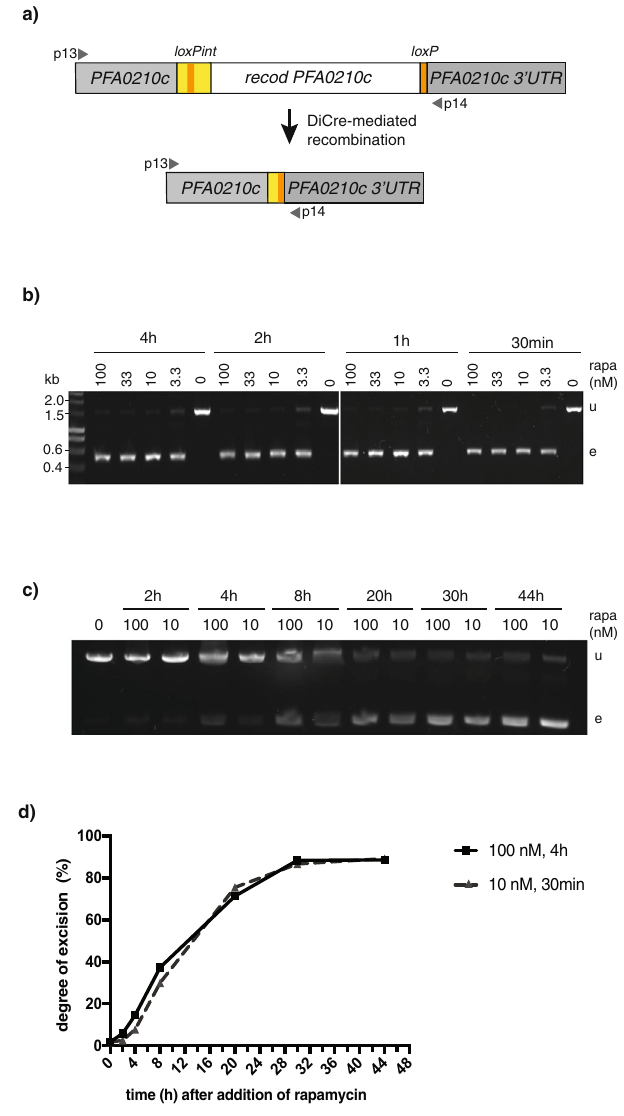
Figure 1. Optimisation of rapamycin-induced recombination. ( a ) Parasites containing a modified PFA0210c 22 were used to test DiCre-mediated recombination efficiency. For this a recodonised version of part of the ORF of PFA0210c was flanked by a loxPint sequence upstream and a loxP sequence downstream located within the endogenous locus on chromosome 1 in the 1G5DC parasite line. ( b ) The efficiency of excision was tested whilst altering the concentration and length of exposure to rapamycin (rapa). Either DMSO alone (0 nM) or increasing concentrations (in nM) of rapamycin were added to transgenic PFA0210c-loxP parasites as indicated for 4, 2, 1 h or 30 min. The degree of recombination was determined by PCR using primers 13 and 14 depicted as arrows in panel a). A lack of recombination and no excision resulted in a PCR product of 1580 bp (u) whereas successful excision resulted in a 562 bp product ( e ). The sizes of DNA markers (in kb) are depicted on the left. ( c ) The timing of excision was determined following addition of either 100 nM rapamycin for 4 h (100) or 10 nM rapamycin for 30 min (10) at very early ring stages. Parasites were harvested 2, 4, 8, 20, 30 or 44 h after the onset of treatment. Genomic DNA was extracted from saponin-treated parasite pellets and excision was determined by PCR as described in panel b. ( d ) Graph depicting the degree of excision (in %) over time elapsed after start of rapamycin treatment. For this graph, the data in panel c) was semi-quantitatively analysed. Pixel intensities of stained DNA bands were measured using ImageJ and the ratio of excised vs. unexcised was plotted against time after rapamycin addition, comparing two treatment methods (100 nM rapamycin for 4 h and 10 nM rapamycin for 30